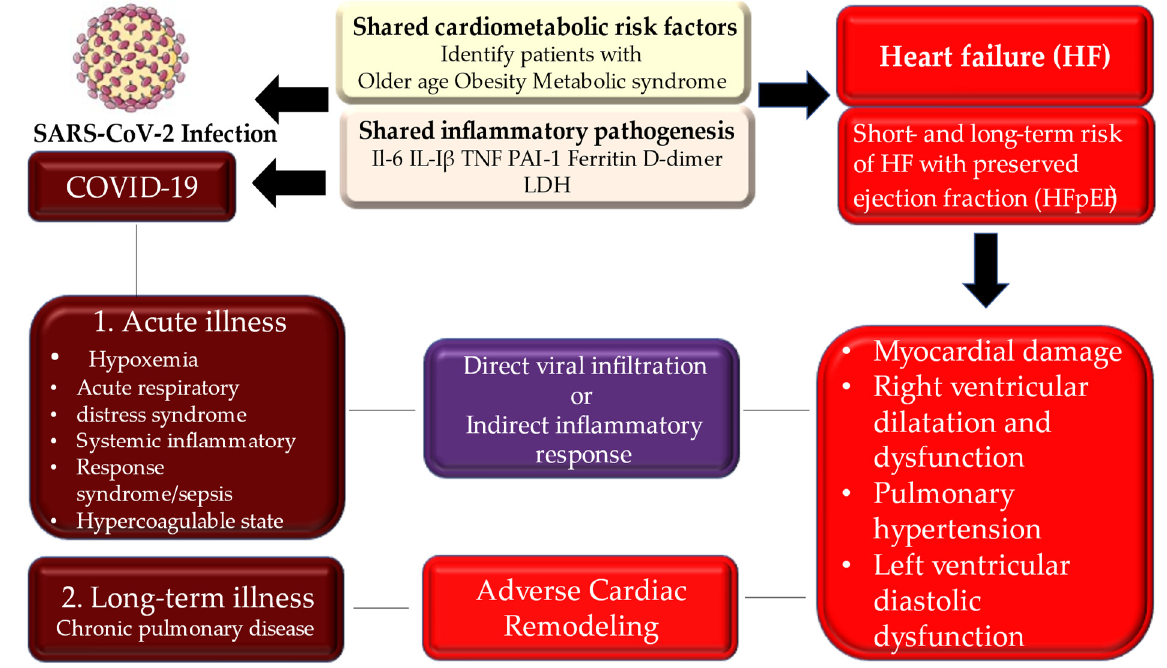
Figure 4. Depicts the potential intersection of acute and chronic phases of COVID-19 and risk of heart failure with preserved ejection fraction. Population at higher risk of infection and development of disease may experience an acute illness or progression toward a long-term illness. Direct viral infiltration or indirect inflammatory response, as well as adverse cardiac remodelling, can lead to chronic heart and pulmonary disease. Abbreviations: COVID-19 indicates coronavirus disease 2019; IL: interleukine; HF, heart failure; LDH, lactate dehydrogenase; PAI-1, plasminogen activator inhibitor 1; TNF, tumor necrosis factor.